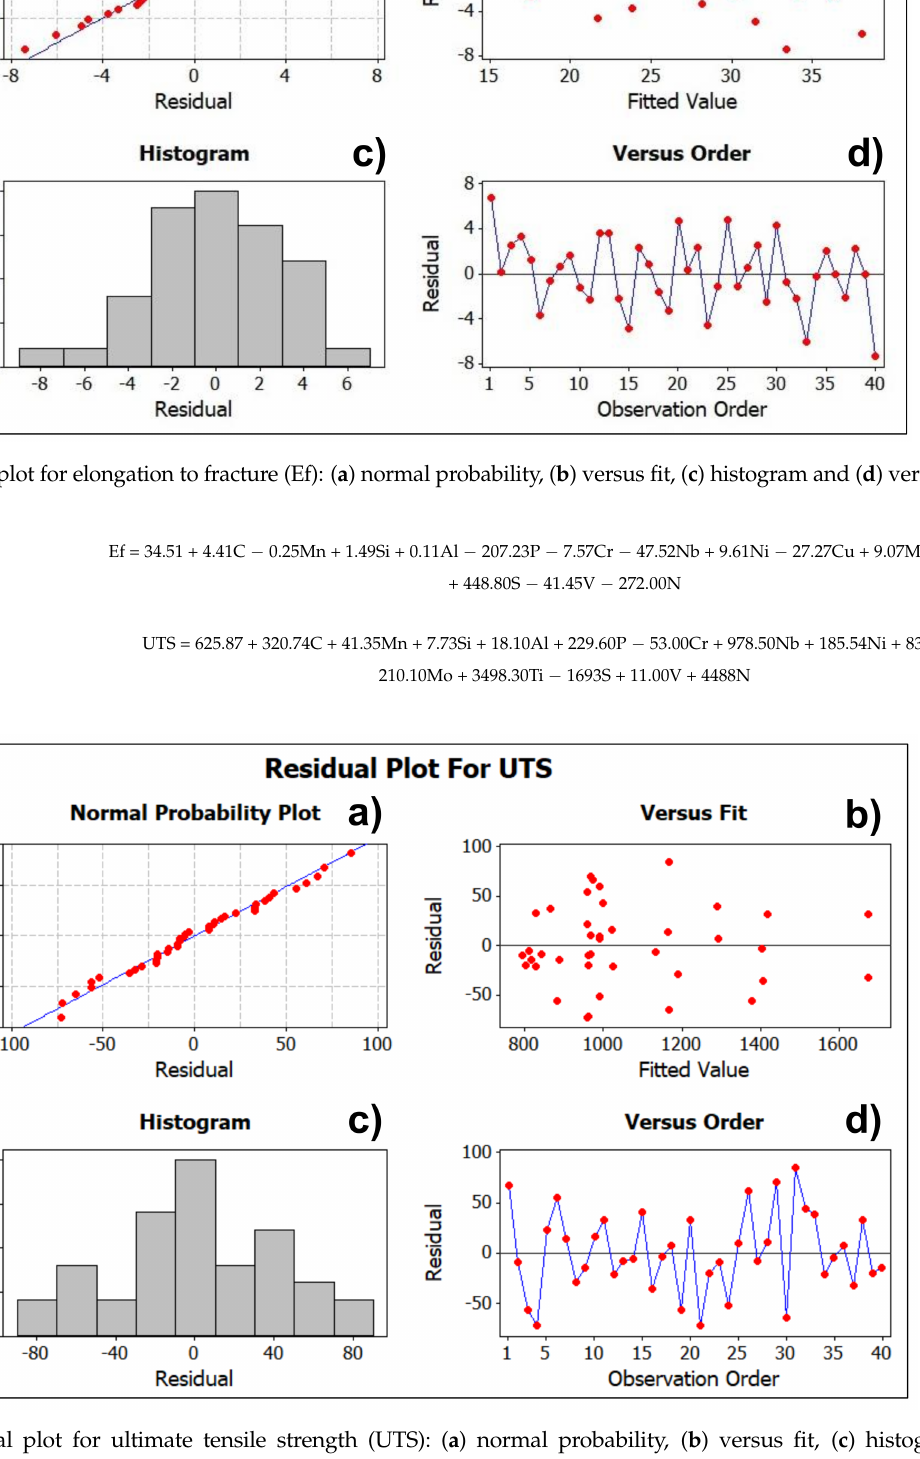
Figure 4. Residual plot for ultimate tensile strength (UTS): ( a ) normal probability, ( b ) versus fit, ( c ) histogram and ( d ) versus